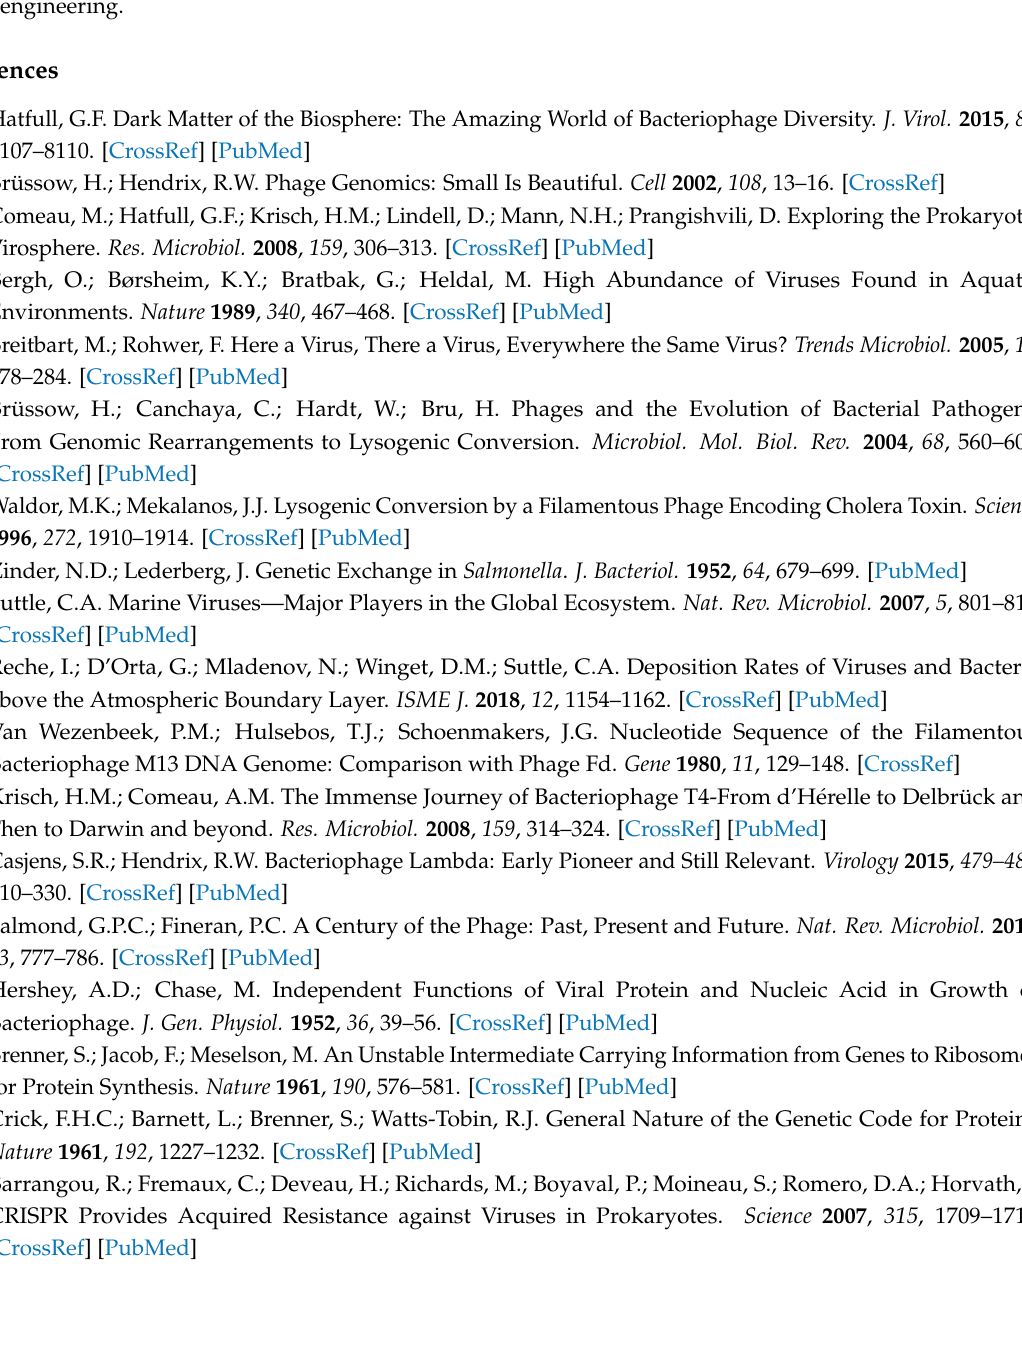
Table S1: Characteristics of complete phage genomes listed in the NCBI